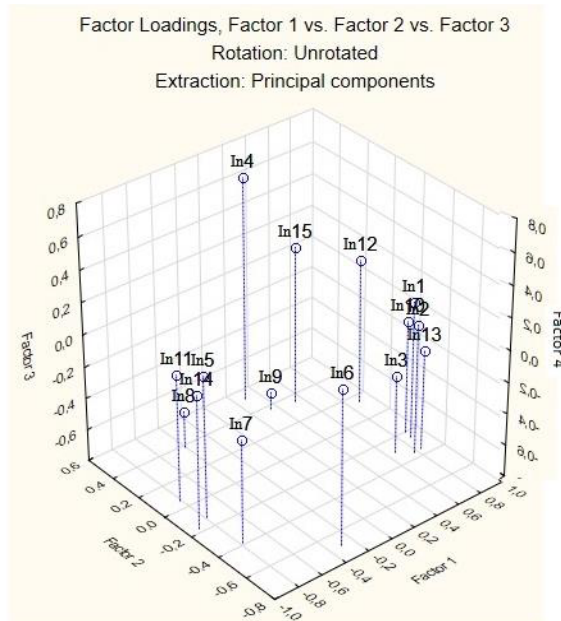
Fig. 5: Observational density graph around the mean value of each group of model factors